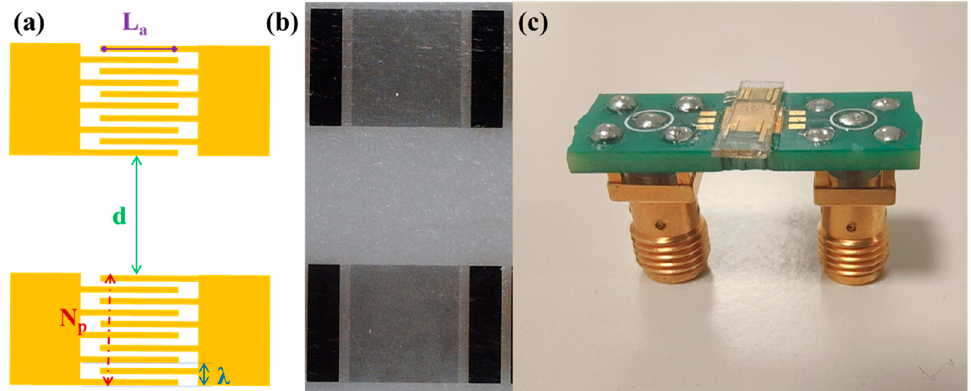
Figure 1. (a) Schematic of a SAW delay line illustrating the design features parametrically changed in the optimization study. (b) Optical microscope images of a SAW delay line and (c) a SAW device connected to a printed circuit board.